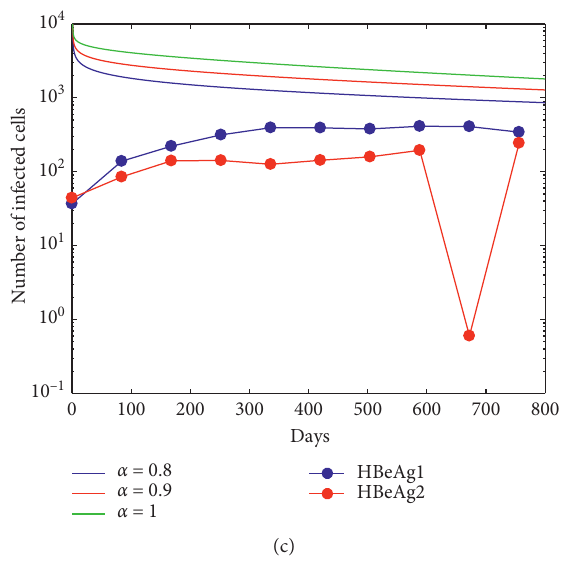
Figure 3: Simulation results of successful-treatment